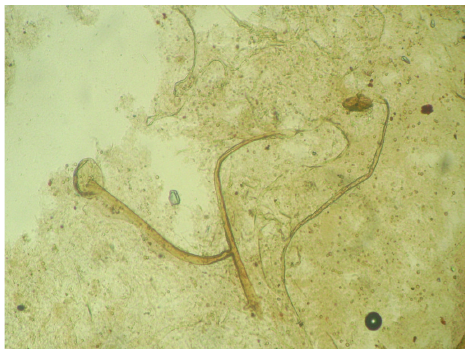
Figure 1: Direct wet mount preparation of tissue showing nodal sporangiophore with umbrella-shaped appearance of sporangium (40x).